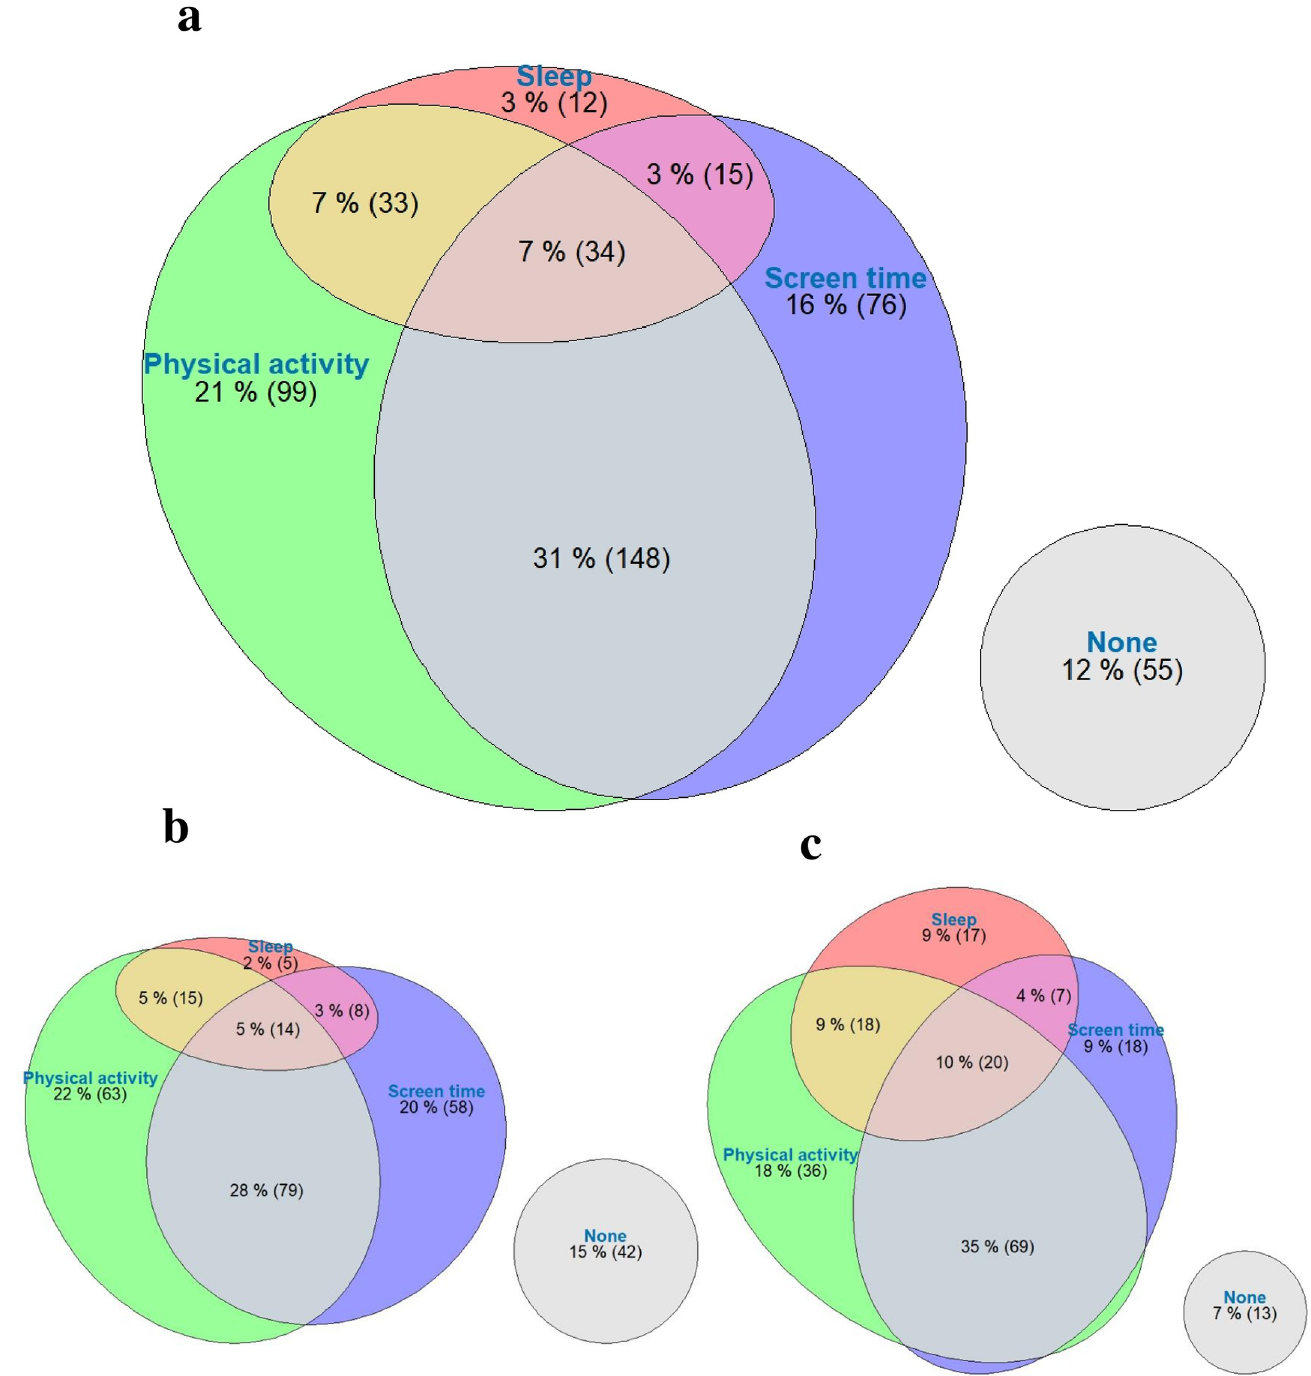
Fig 1. Venn diagram showing the percentage of children (N = 481) meeting the physical activity screen time and sleep recommendations and the combination of these behaviours. The ellipse size is proportional to the proportion meeting the recommendations. a all participants, b rural participants, c urban